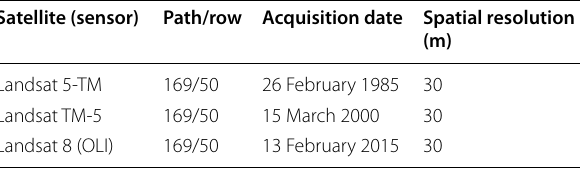
Table 1 Landsat data used in the analysis and their speci- fication